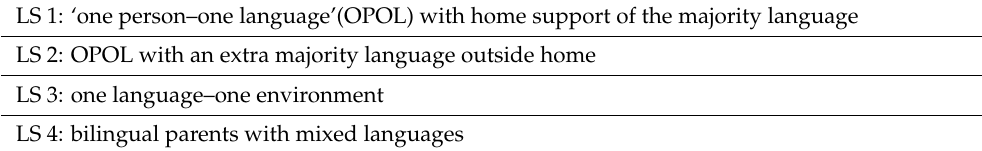
Table 5. Family language strategies (adapted from Arnaus Gil et al. 2020, p. 3).